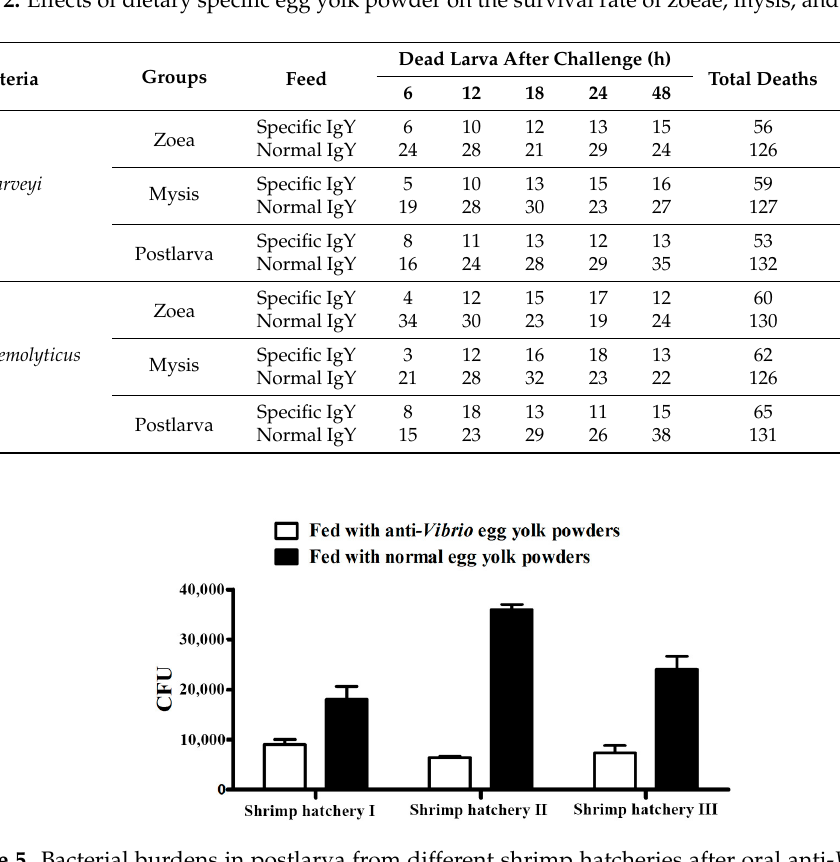
Figure 5. Bacterial burdens in postlarva from different shrimp hatcheries after oral anti- Vibrio yolk powder. Data are presented as CFU per g of postlarva. Bacterial burdens are significantly different with different treatments ( p < 0.05). The results shown are the average of three independent experiments.